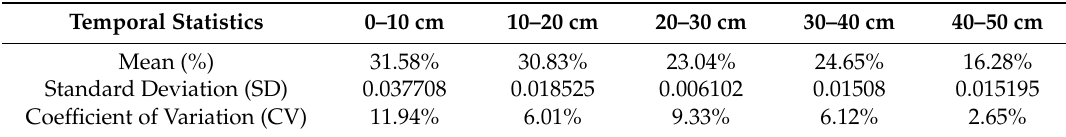
Table 2. Temporal statistics (September 2016–August 2017) for mean soil moisture, the standard deviation, and the coefficient of variation in multiple soil layers.